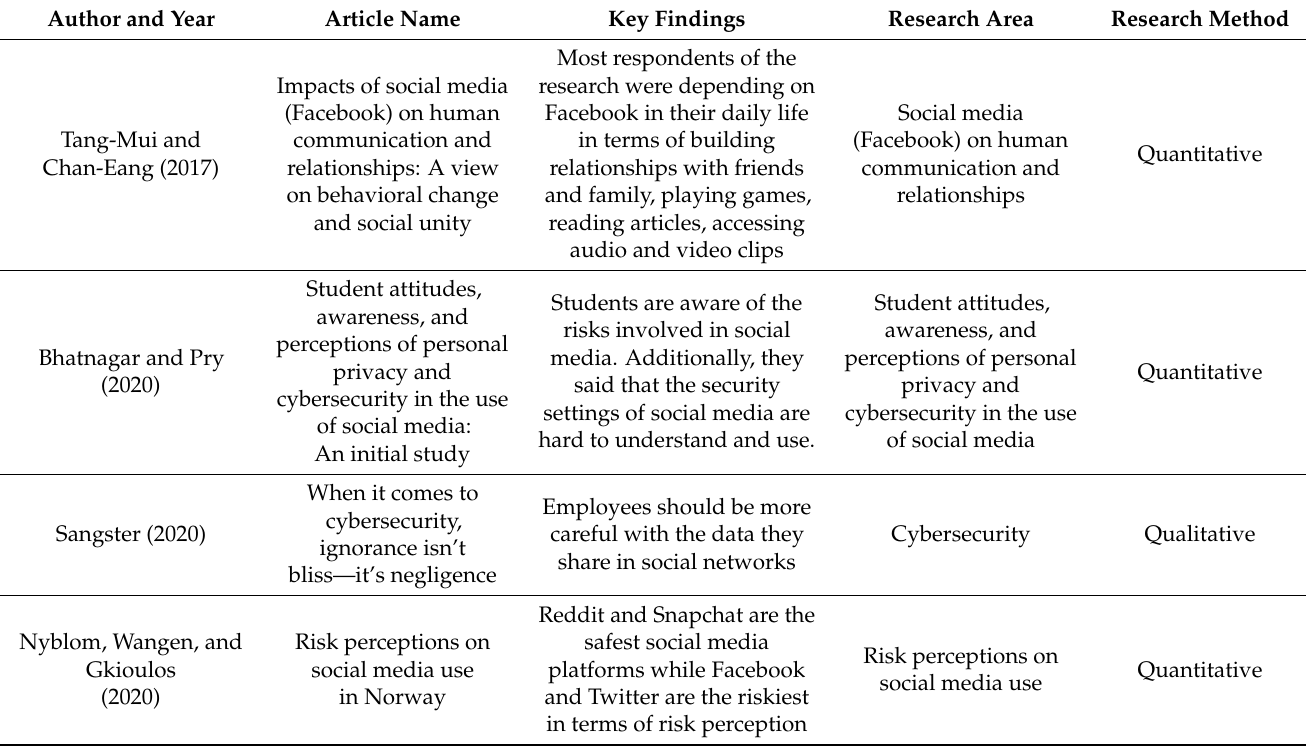
Table A6. Cybersecurity on social media.